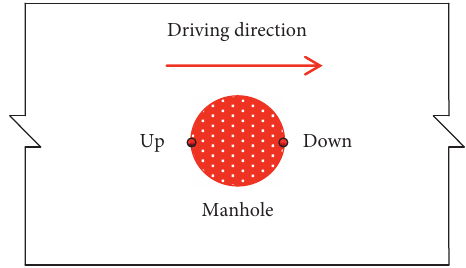
Figure 2: “Up” point and “Down” point of Table 1: Investigation data of pavement damage and manhole settlement. Road names